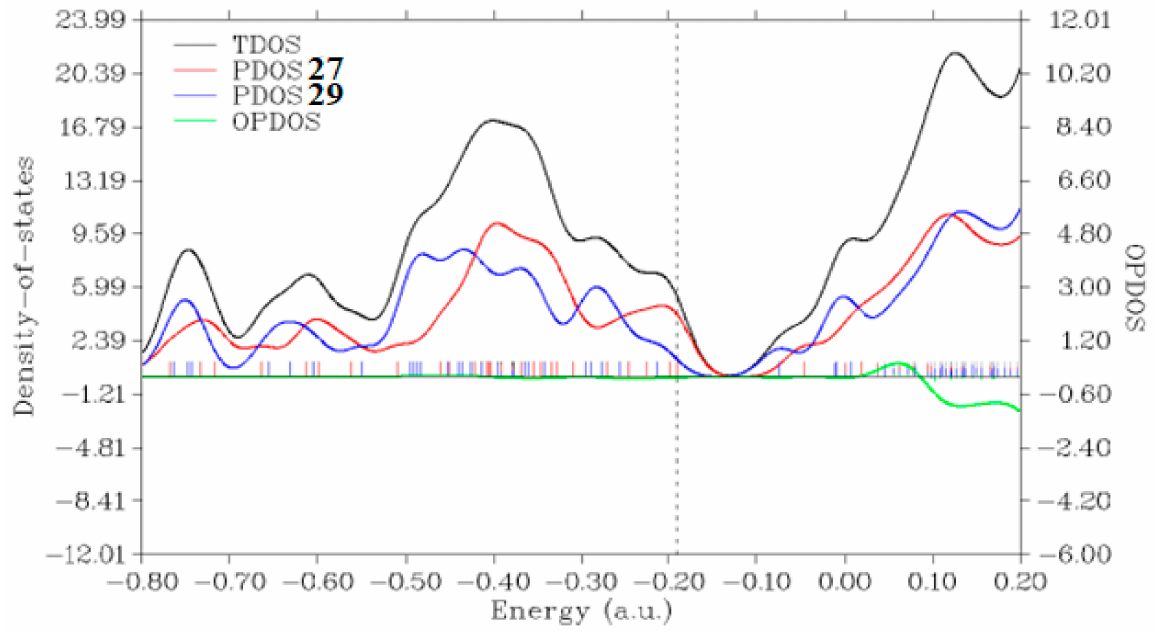
Figure 10. Electronic Density of States (DOS) of the unreacted complex of 29 with 27 at the B3LYP- D4/def2-TZVP level in implicit ethanol as solvent. Total DOS (black) and projected DOS on the reactant 29 (blue) and 27 (red) molecules. The overlap population DOS (OPDOS) is given by the green curve which shows the negligible overlap between MOs below the LUMO level. The vertical dashed line indicates the energy position of the HOMO. The eigenvalues of the Kohn–Sham are indicated by the vertical spikes. Energy units are in hartree and DOS is in hartree − 1 .